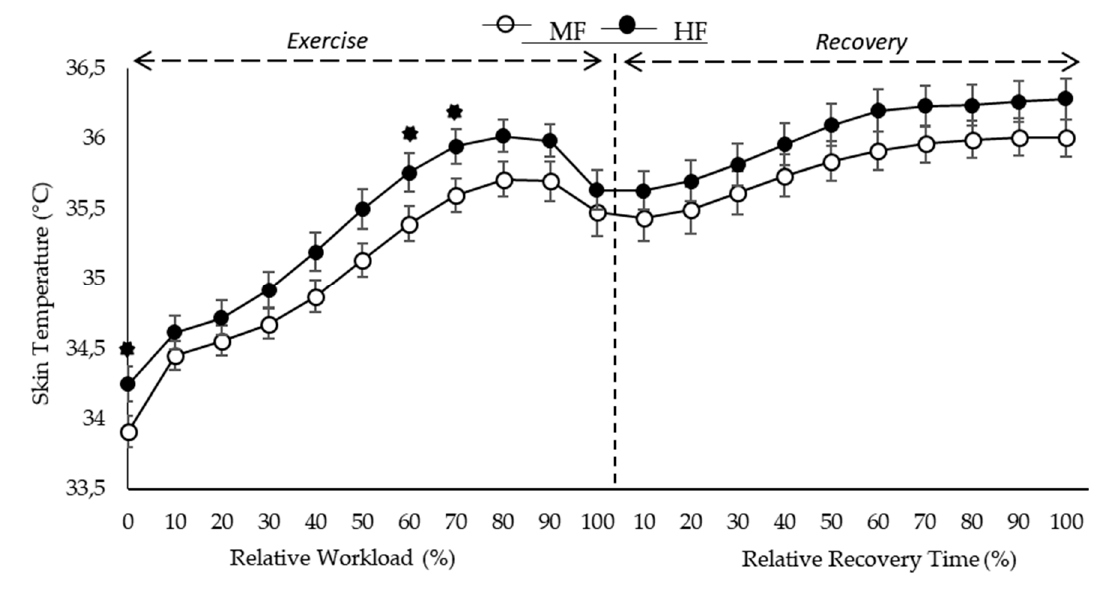
Figure 1. Values are means ± SEM. The black circles represent the highly fit endurance runners (HF) group and the white circles represent the moderately fit endurance runners (MF) group. Significant level was set at p < 0.05. Analysis was performed at the end of each relative workload of exercise and recovery period. * Significant differences between highly and moderately fit endurance runners.